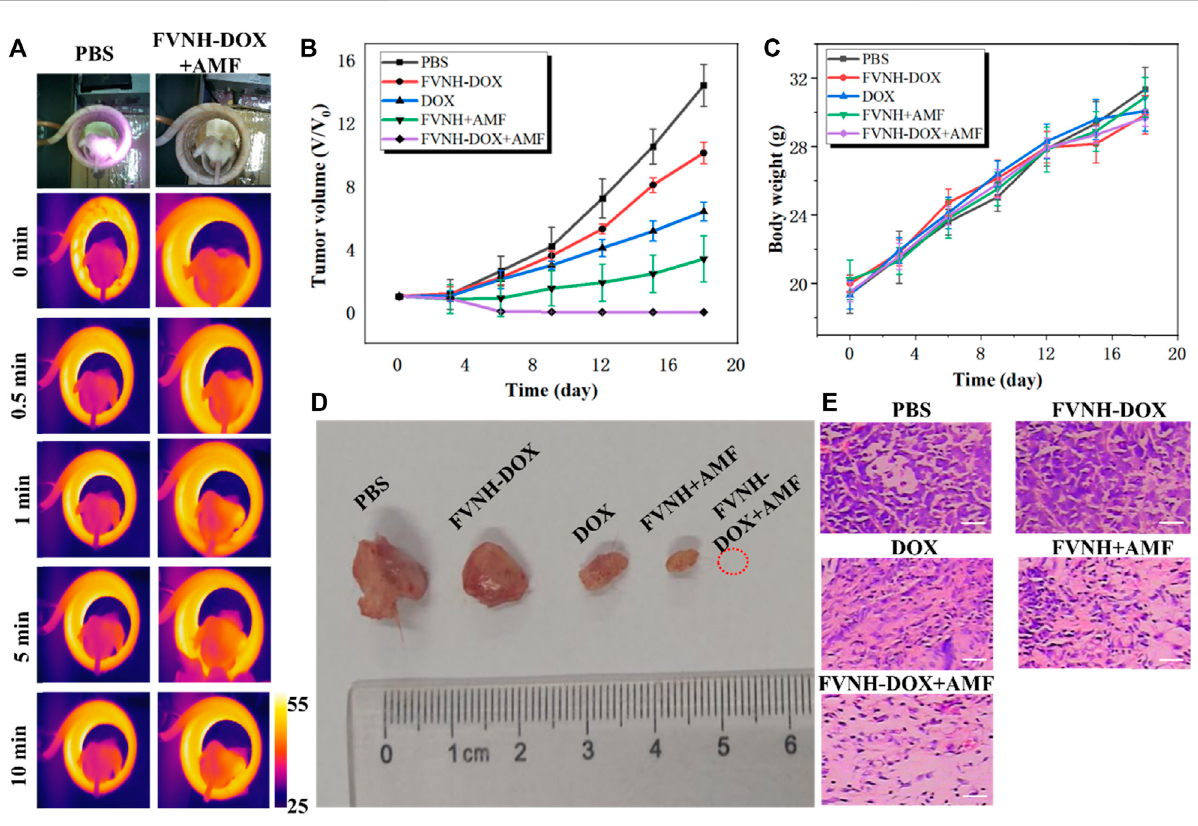
FIGURE 7 In vivo cancer magnetothermal-chemotherapy in tumor-bearing mice models with 4T1 cancer cells. (A) Photos and corresponding thermal images of tumor-bearing mice under AMF at different time points after injection with PBS or FVNH-DOX; (B) The relative tumor growth curves of differentgroups; (C) Bodyweightcurvesfordifferentgroupsaftertreatment; (D) Representativetumorspicturefromdifferenttreatmentgroupsafter the experiments; (E) The H&E images of tumors collected from different treated groups. (Scale bar = 100 μ